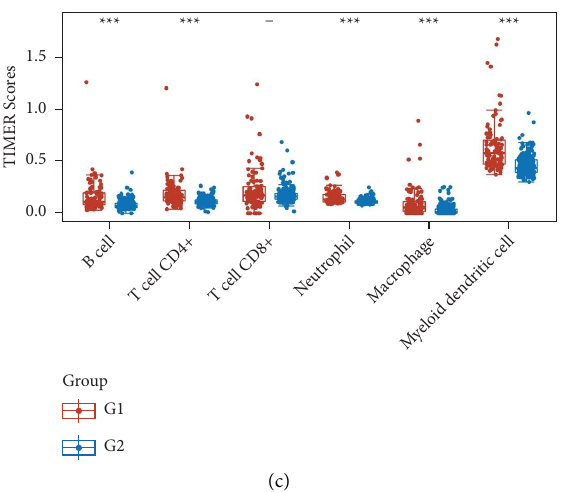
Figure 6: (a) Identifying immune checkpoint genes that are expressed diferently in high-risk and low-risk populations. (b) Scores of immunotherapy response in high- and low-risk groups. (c) Spearman’s correlation analysis between model scores and immune cell